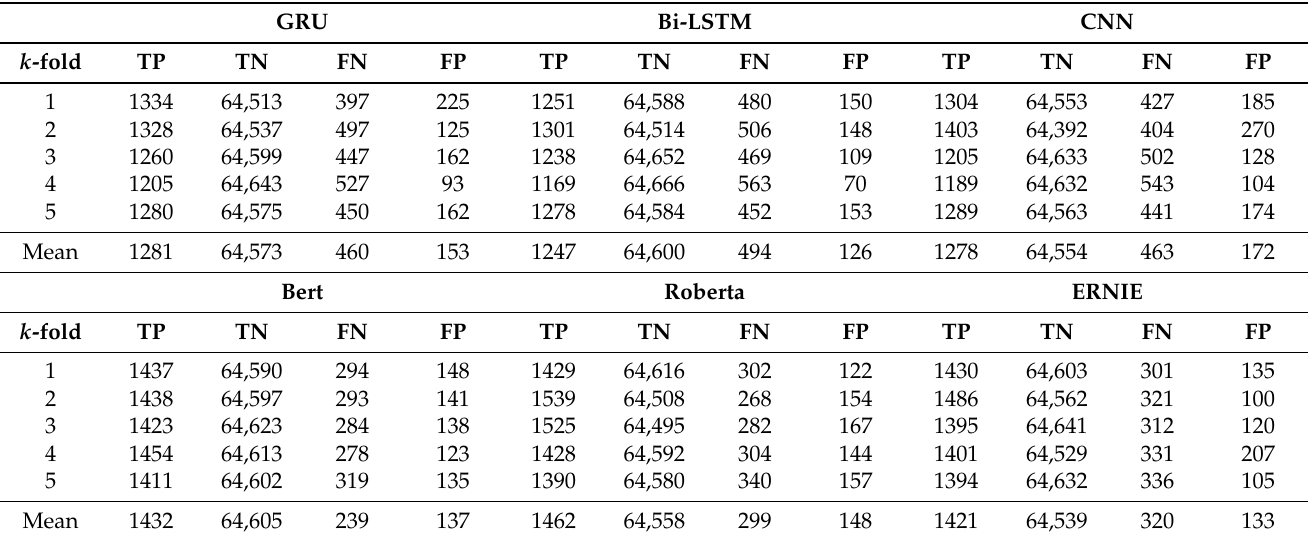
Table 6. The k -fold cross-validation with all data (Combine_All as described in Section 3) segmented in into five folds. We split data into 80:20 splits for training and testing by ensuring the testing set did not contain any records from the training set. We applied transformers (BERT, RoBERTa and ERNIE 2.0) and DL algorithms (GRU, Bi-LSTM and